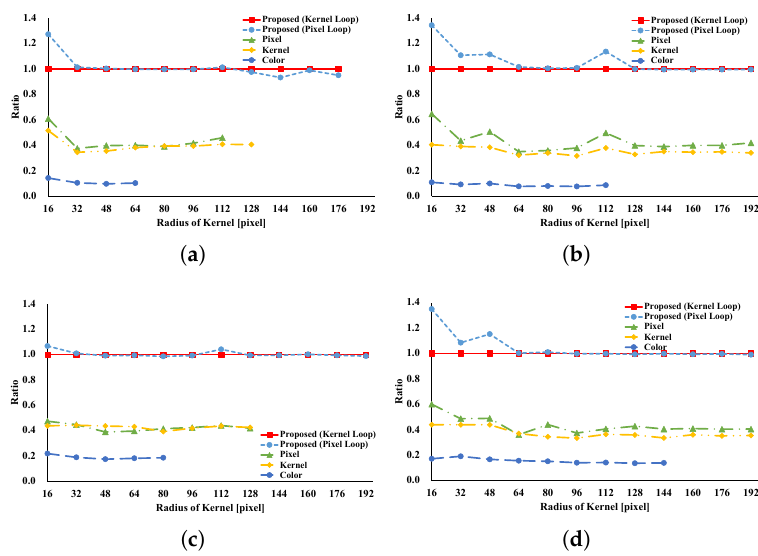
Figure 15. The speedup ratio of randomly-kernel-subsampled Gaussian range filtering (RKS-GRF) with respect to the kernel radius of FIR filtering. ( a ) 1/4 subsample in weight computation; ( b ) 1/16 subsample in weight computation; ( c ) 1/4 subsample in LUT; ( d ) 1/16 subsample in LUT. If the ratio exceeds 1, the pattern is faster than kernel loop